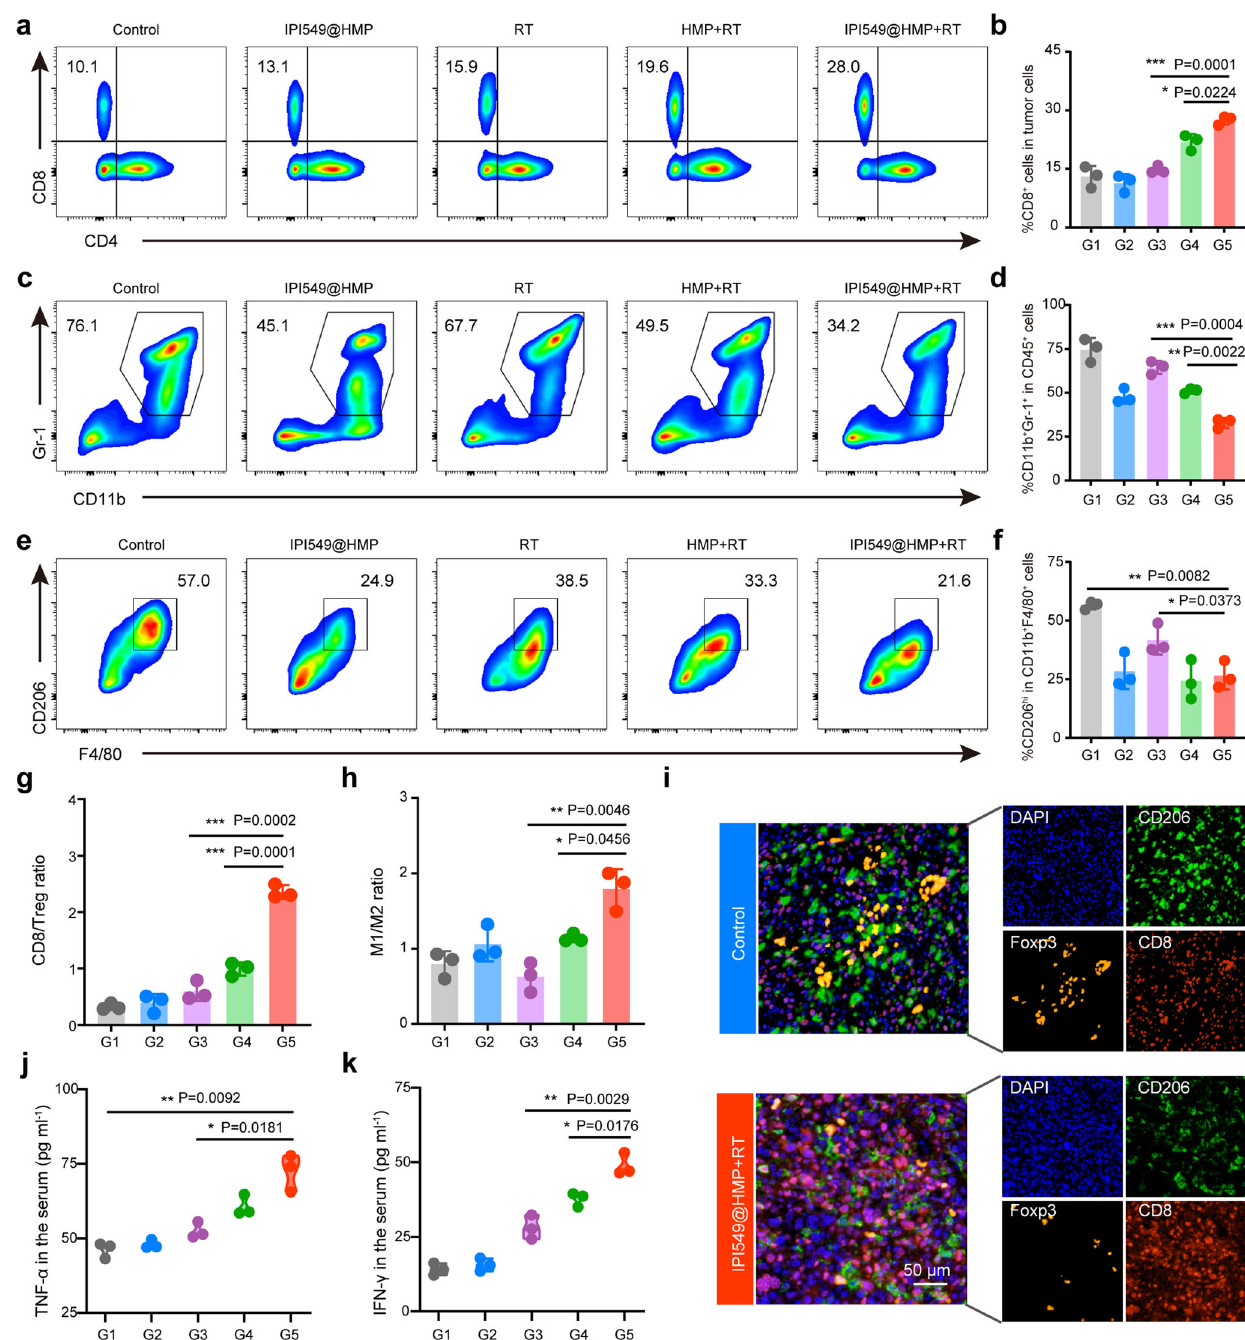
Fig. 6 Robust antitumor immune responses triggered by IPI549@HMP-augmented RT. a – f Representative fl ow cytometric analysis and relative quanti fi cation of CTLs (CD8 + CD3 + CD45 + ) ( a , b ), MDSCs (CD11b + Gr-1 + CD45 + ) ( c , d ) and TAM-M2 (CD206 hi CD11b + F4/80 + CD45 + ) ( e , f ). g , h Quanti fi cation by fl ow cytometry of CD8/Treg ( g ) and M1/M2 ratios ( h ). i Representative polychromatic immuno fl uorescent staining images of tumors from three biologically independent samples showing DAPI (blue), CD206 + (green), Foxp3 + (orange) and CD8 + (red) cells in fi ltration for Control and IPI549@HMP + RT groups. j , k Cytokine levels of TNF- α ( j ) and IFN- γ ( k ) in the serum after varied treatments. G1, Control; G2, IPI549@HMP; G3, RT; G4, HMP + RT; G5, IPI549@HMP + RT. RT, radiotherapy; CTLs, cytotoxic T lymphocytes; Tregs, regulatory T cells; MDSCs, myeloid-derived suppressor cells; TAMs-M2, M2-like macrophages; TAMs-M1, M1-like macrophages. Data were expressed as means ± SD ( n = 3 biologically independent samples in b , d , f , g , h , j , and k ). Statistical difference was calculated using two-tailed unpaired student ’ s t -test. * P < 0.05, ** P < 0.01, *** P < 0.001. Source data are provided as a Source Data fi